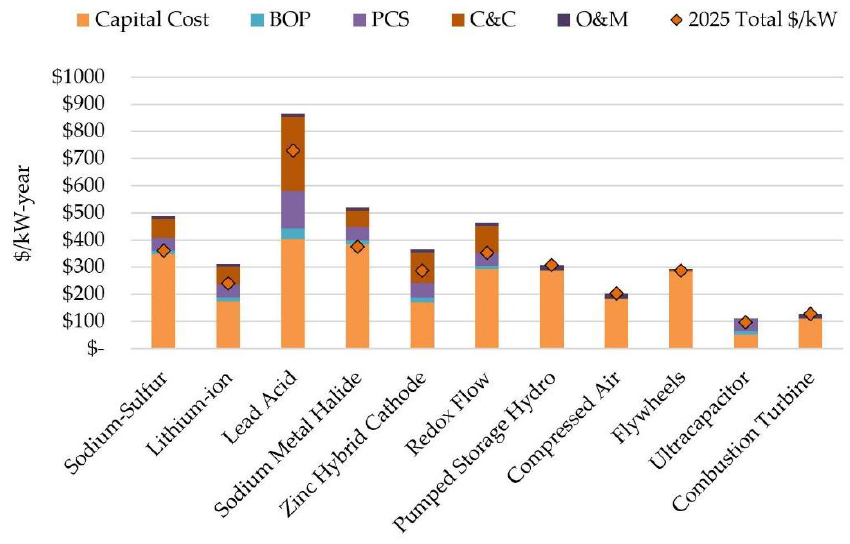
Figure 4. Annualized costs for each technology by cost component.